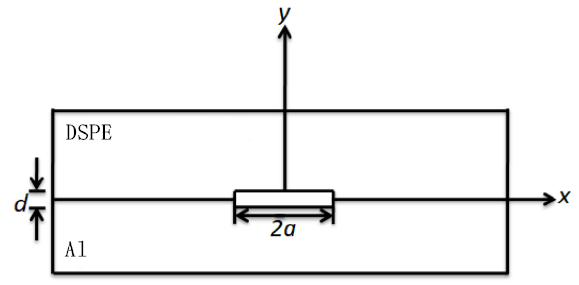
Figure 6. Bonding interface model.